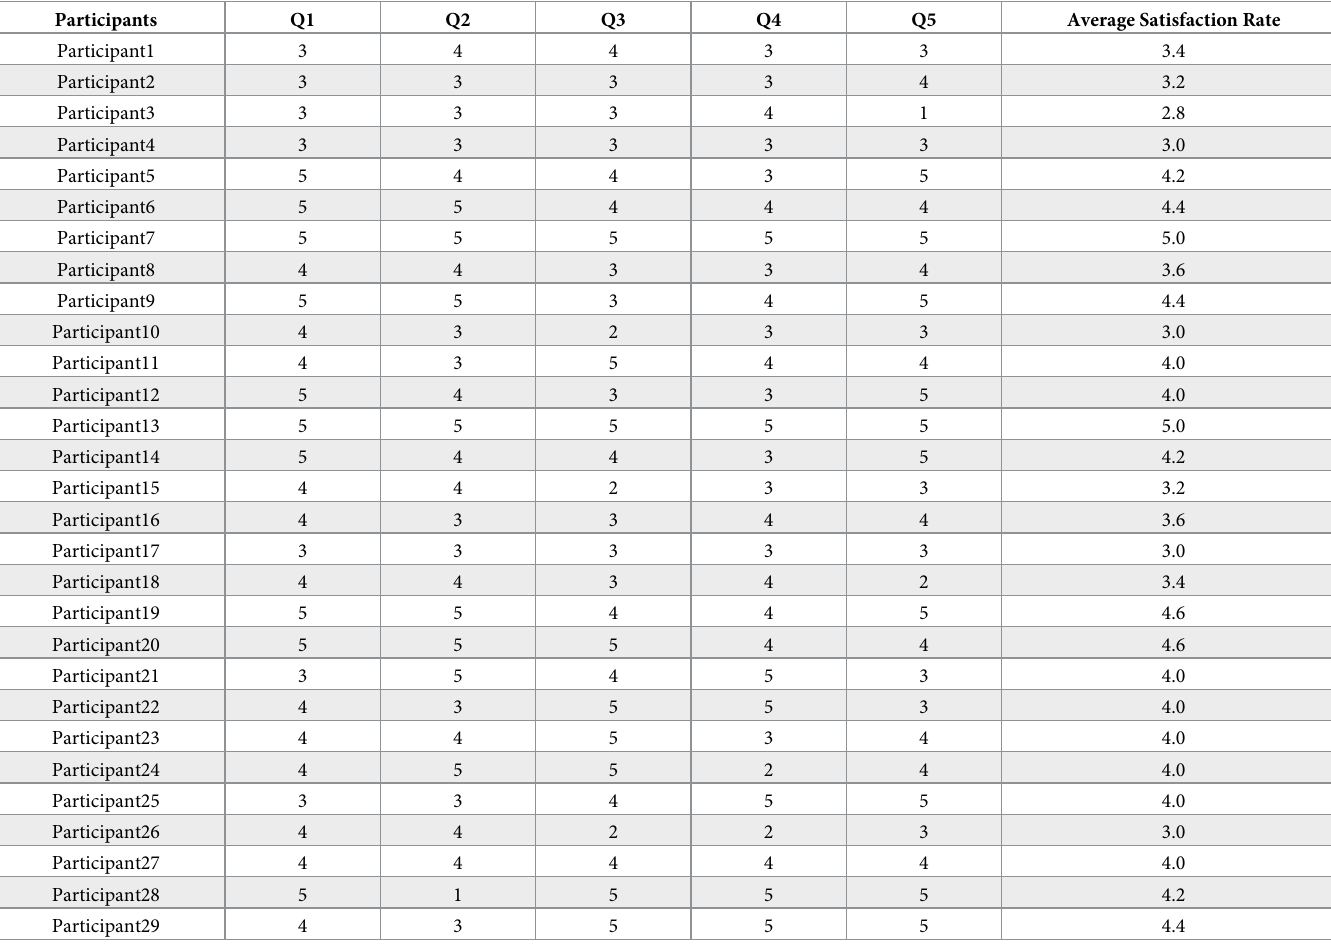
Table 7. User satisfaction and